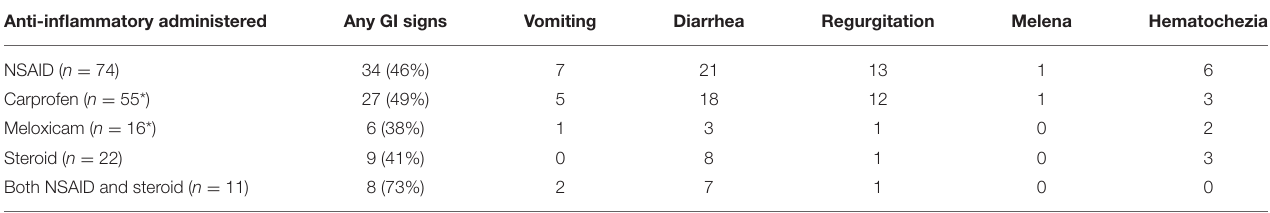
TABLE 3 | Frequency of GI signs in 107 of 116 dogs undergoing surgery for TL-IVDE and receiving perioperative anti-inflammatory medications. Anti-inflammatory administered Any GI signs Vomiting Diarrhea Regurgitation Melena